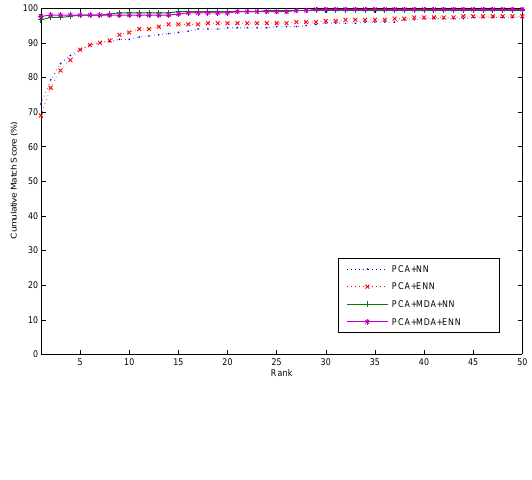
Fig. 6. The distribution of 15 final feature vectors belonging to five subjects (only the first three-dimensional eigenspace is used for visualization).